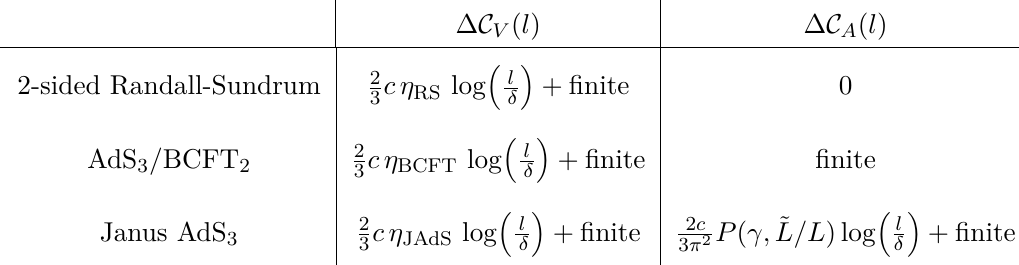
Table 1 . Behaviour of the contributions of the defect ∆ C V and ∆ C A to the subregion complexity, for an interval of length l for CV and CA, respectively. The coefficients of the log divergences η are specific of the details of the defect or boundary. In the case of Janus geometry, η JAdS is given in eq. (3.110). For the other models, the η coefficients can be extracted from [59, 64, 65, 68]; their specific values are not essential for the present discussion. The function P ( γ, ˜ L/L ) is given in eq.